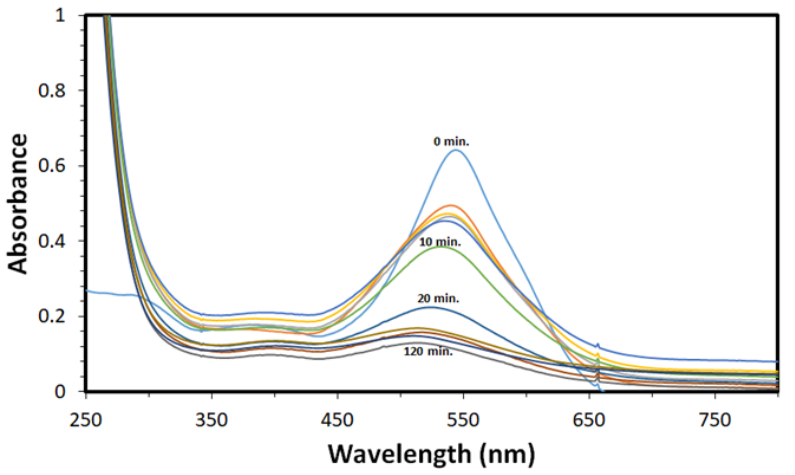
Figure 8. The variation of the uv-vis absorbance with time for the removal of DV31 dye from aqueous solution using G CuO NPs. (Experimental conditions: DV31 dye concentration 25 mg/L; sample volume 200 mL; 20.0 mg CuO NPs; 1 mL H 2 O 2 ; pH 8.6 and temperature at 25 °C).